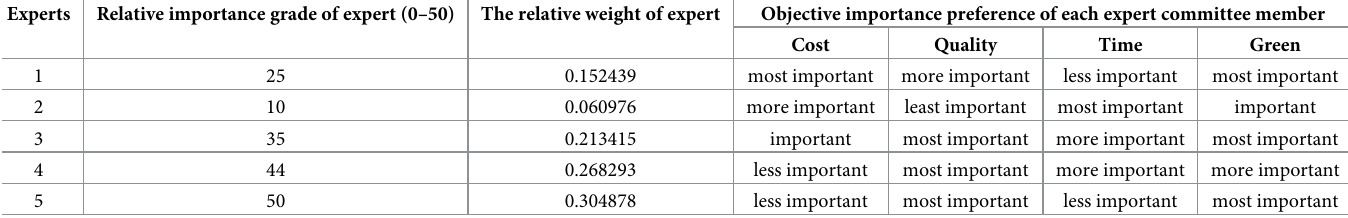
Table 13. Determination of normalized fuzzy weights using experts’ opinion. Experts Relative importance grade of expert